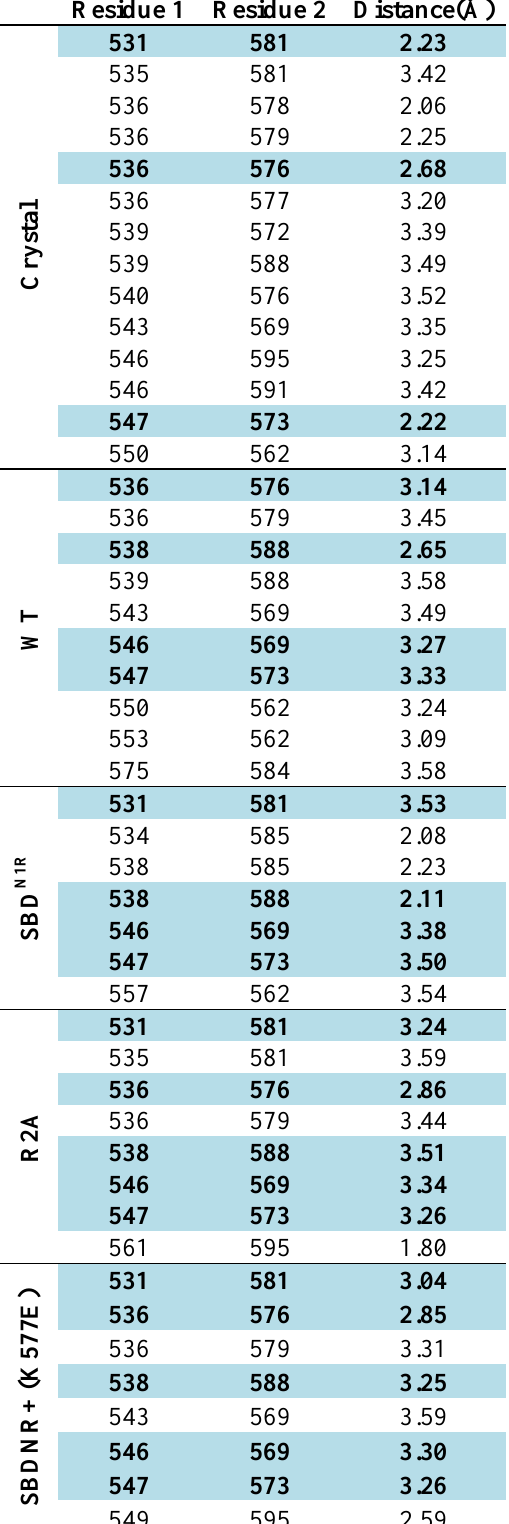
Table 2. The geometric mean distance between residues on helices B, C and D of DnaK complex with the NR peptide. Only pairs for which the mean distance is not greater than 3.5 Å are shown. Common contacts, which appear in most of the simulations, are marked in